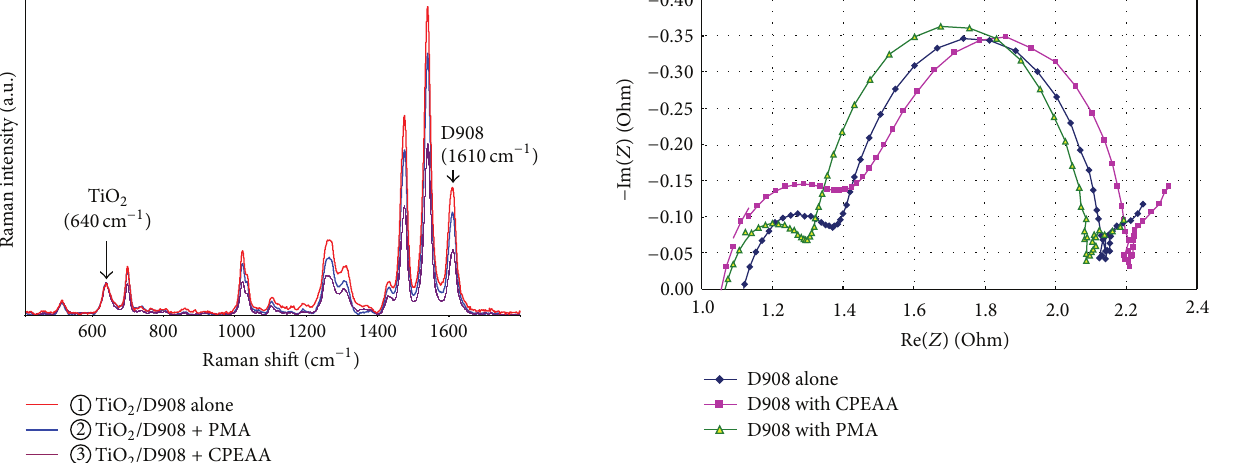
Figure 5: Raman spectra of the TiO 2 films sensitized with D908 alone, D908 with PMA, and D908 with CPEAA.